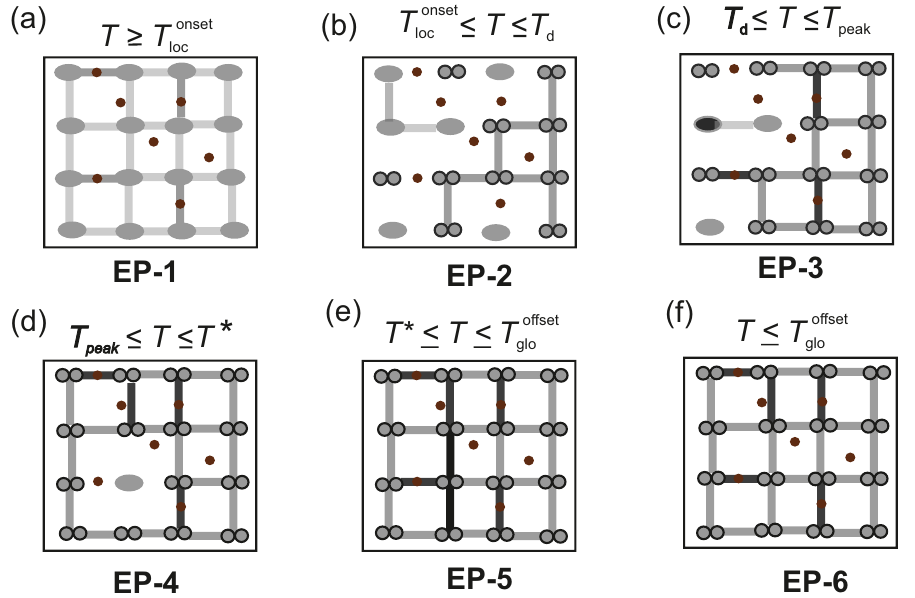
Figure 6. Schematic of the empirical model to describe the N-BI-S transition in #B. The connector lines connecting the ellipses and dumbbells represent fermionic conduction channels and bosonic conduction channels, respectively. The normal state fermions and the Cooper pairs are shown by ellipses and dumbbells, respectively, while the Fe impurities are depicted by solid circles. The electronic phase transitions taking place as the sample #B is cooled from T > T onset down to loc T ≤ T onset are: ( a ) Phase EP-1 for T > T onset . ( b ) Phase EP-2 for T d < T < T onset . ( c ) Phase EP-3 loc loc loc for T peak < T < T d . ( d ) Phase EP-4 for T Peak ≤ T ≤ T ∗ . ( e ) Phase EP-5 for T ∗ ≤ T ≤ T offset glo